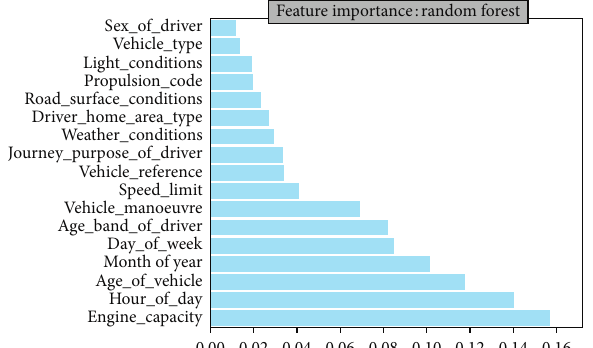
Figure 10: Feature importance results by Random Forests algorithm.